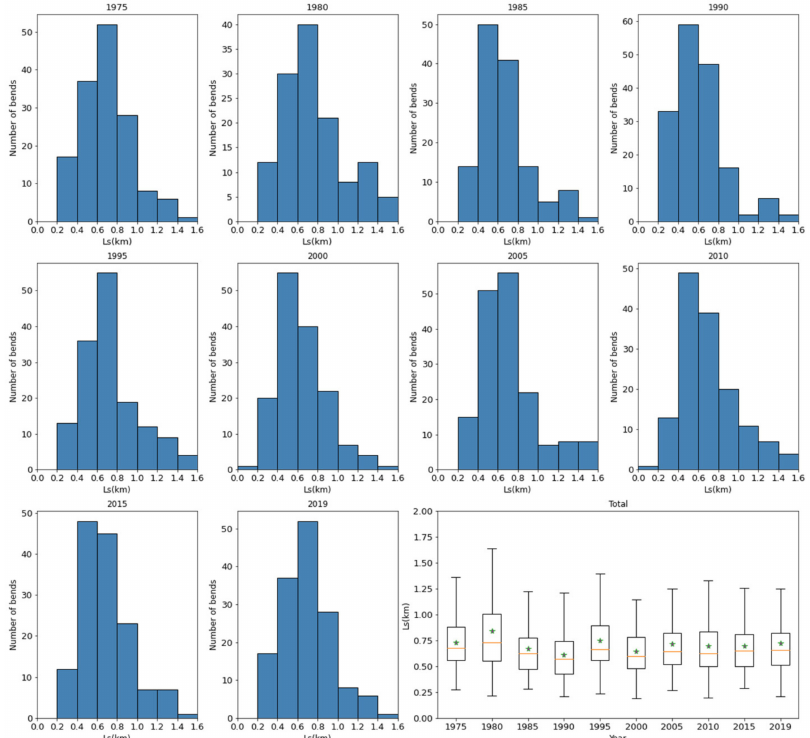
Figure 5. The measured meander amplitude in 1975, 1980, 1985, 1990, 1995, 2000, 2005, 2010, 2015, and 2019.